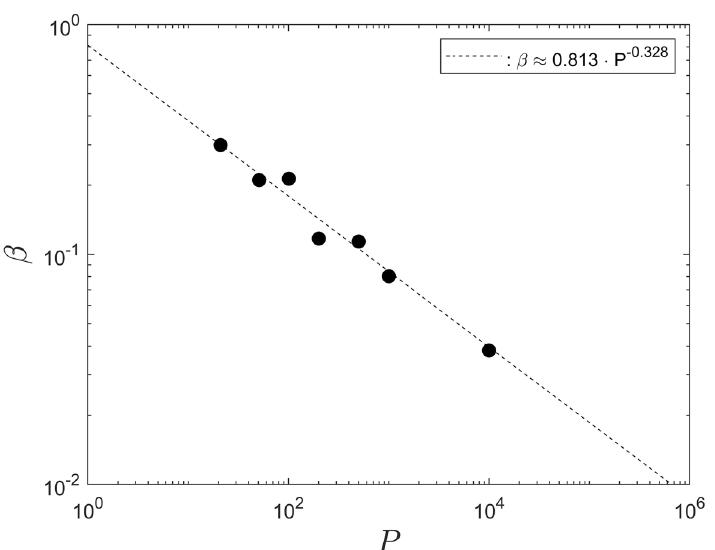
Figure 10. The parameter β as a function of the population size P